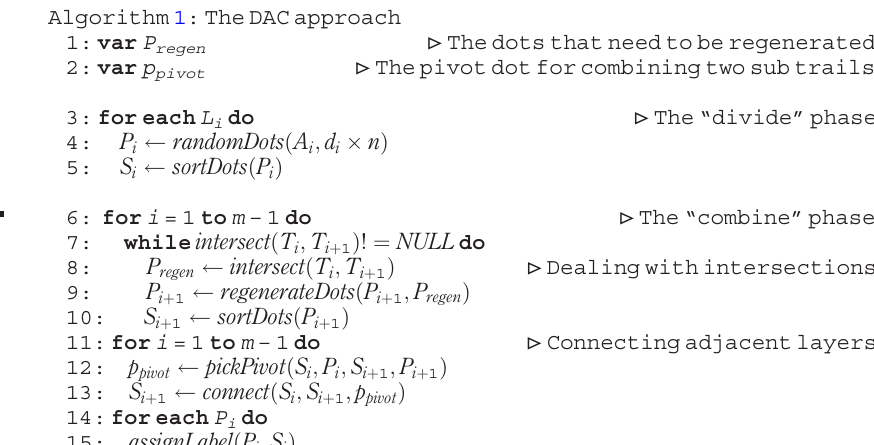
Algorithm 1: The DAC approach 1: var P